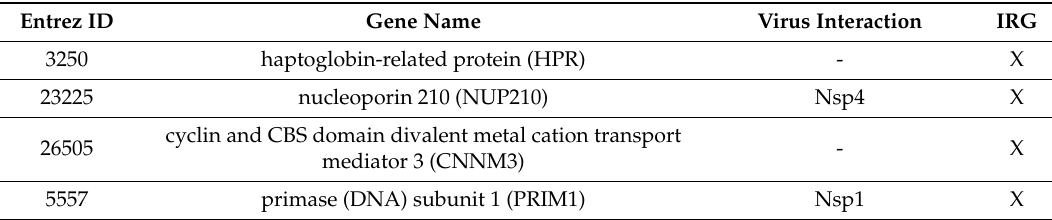
Figure 1. The log 10 ( a ) degree and ( b ) betweenness distributions of the Host Interaction Network (HIN) and Virus Interaction Network (VIN) with the corresponding distributions for the subset of SARS-CoV-2 interacting host proteins. Table 1. The identities of the displaced driver proteins: the proteins that are drivers in the HIN, not the VIN. If the proteins are also virus interacting, viral protein interactor is given along with status as an interferon regulated gene